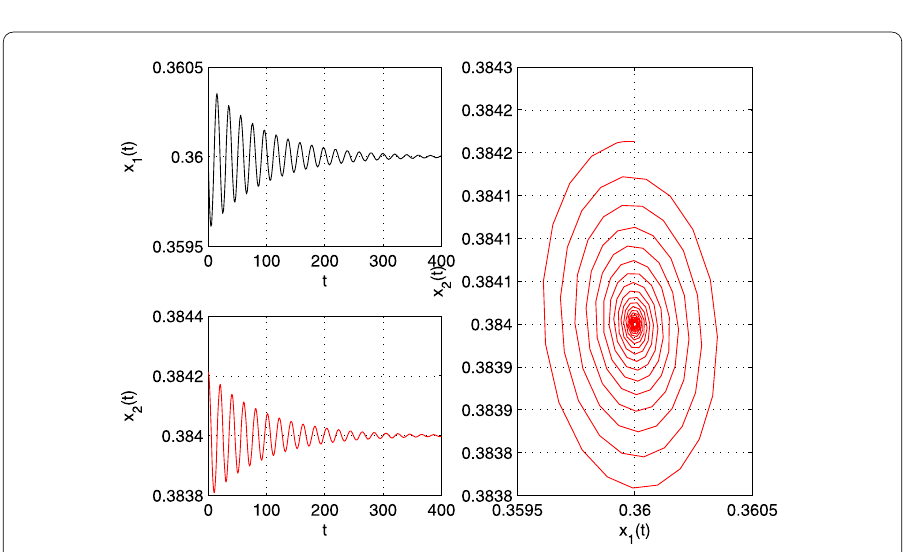
Figure 2 The trajectories of system (4.1) with τ = 0.2. The positive equilibrium E ∗ 3 is asymptotically